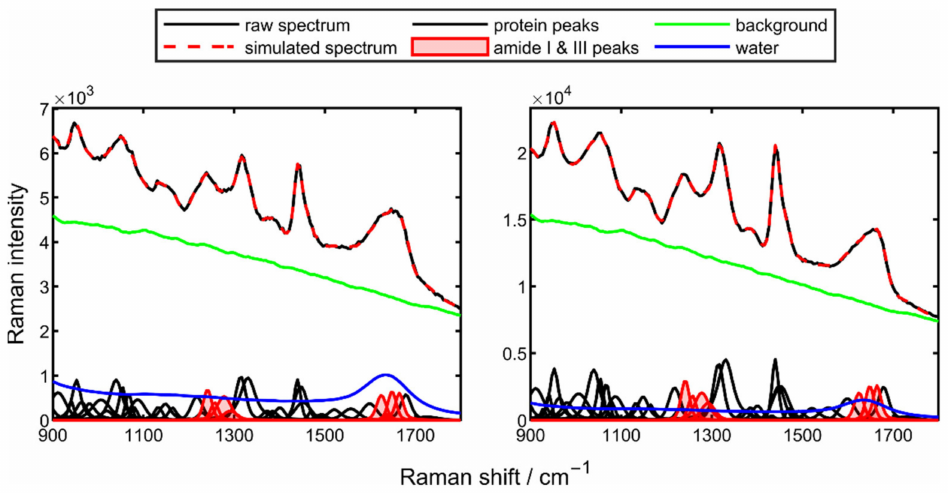
Figure 4. Spectrum of the mathematical reconstruction of the fingerprint region from the drying process of a 10 wt% poly-L-lysine droplet at a drying temperature of 50 ◦ C at the start ( left ) and the end ( right ) of the drying